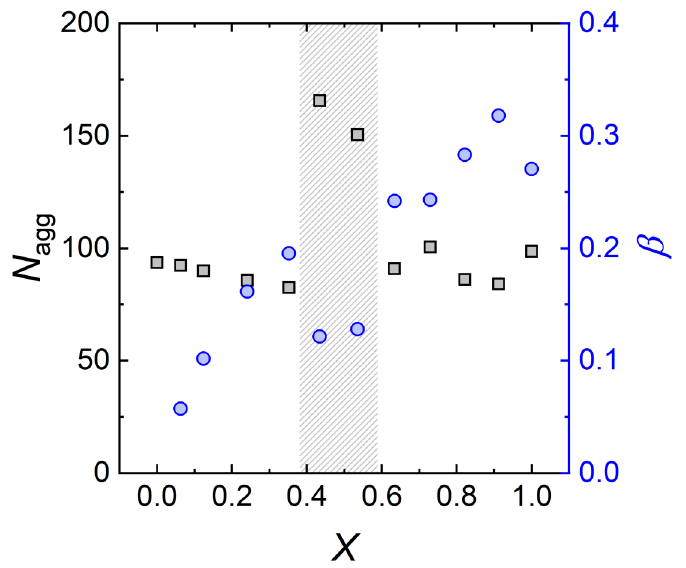
Figure 8. Aggregation number N agg and fraction charge β of the formed mixed SDS/Tween20 micelles determined by the fits of SANS data depending on the SDS molar ratio X